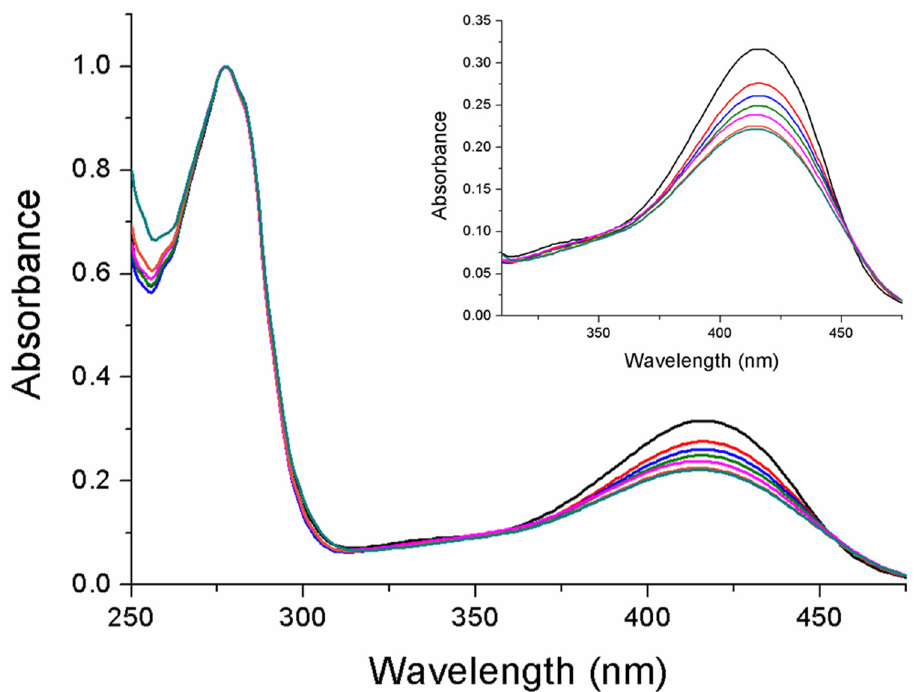
Figure 6. The absorption spectra of the Amico PLP form at a concentration of 30 µM in different buffers: mixed buffer 25 mM Tris-HCl and 25 mM K-phosphate pH 7 (black), pH 8 (red), pH 8.5 (blue), pH 9 (green), 50 mM CHES buffer pH 9 (magenta), pH 9.5 (orange), pH 10 (dark cyan). The insert shows the absorption spectra at 310–465 nm. The spectra were obtained with three independent preparations.